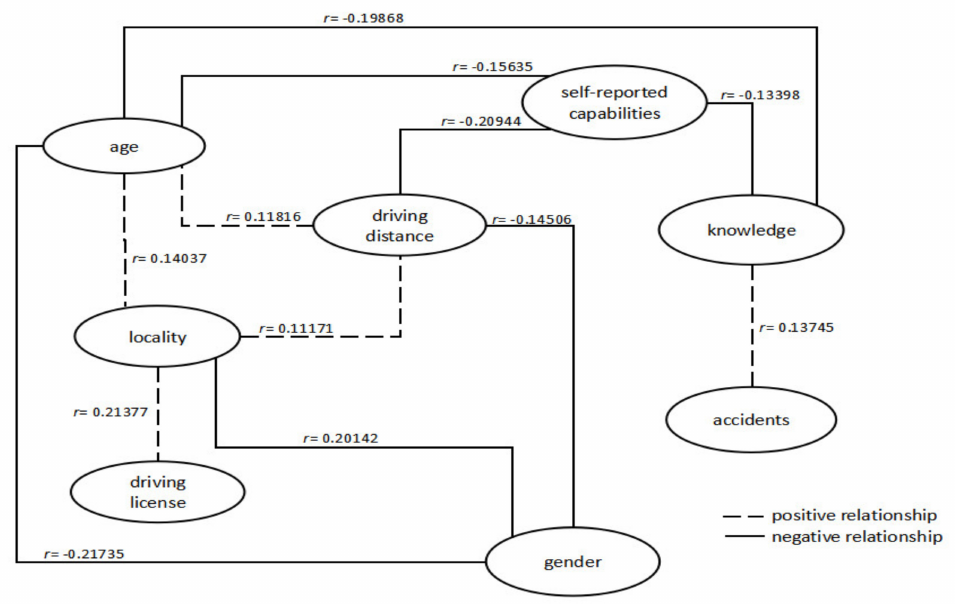
Figure 4. Relationship among PC